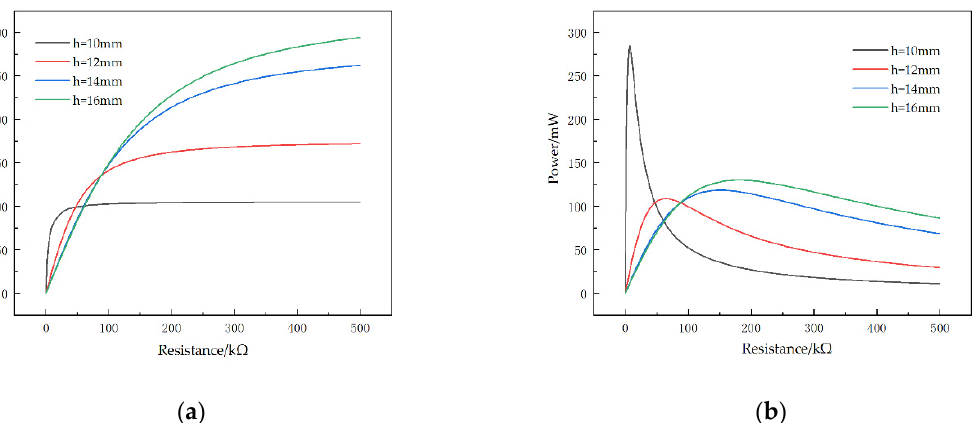
Figure 13. Output performance–resistance curves of the STTM-PEH with different lengths of the T-shaped trapezoidal cantilever head. ( a ) Output voltage–resistance curves. ( b ) Output power–resistance curves.